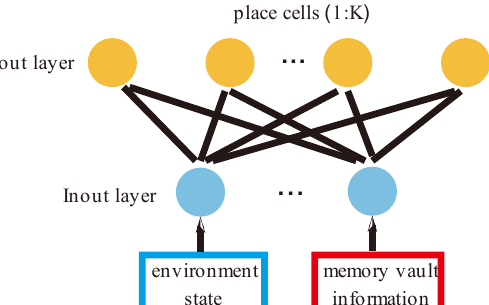
Figure 1. An overall schematic of the model. The square structures represent the anatomical struc- tures that actually exist in the brain, and the oval structures represent the functional structures.